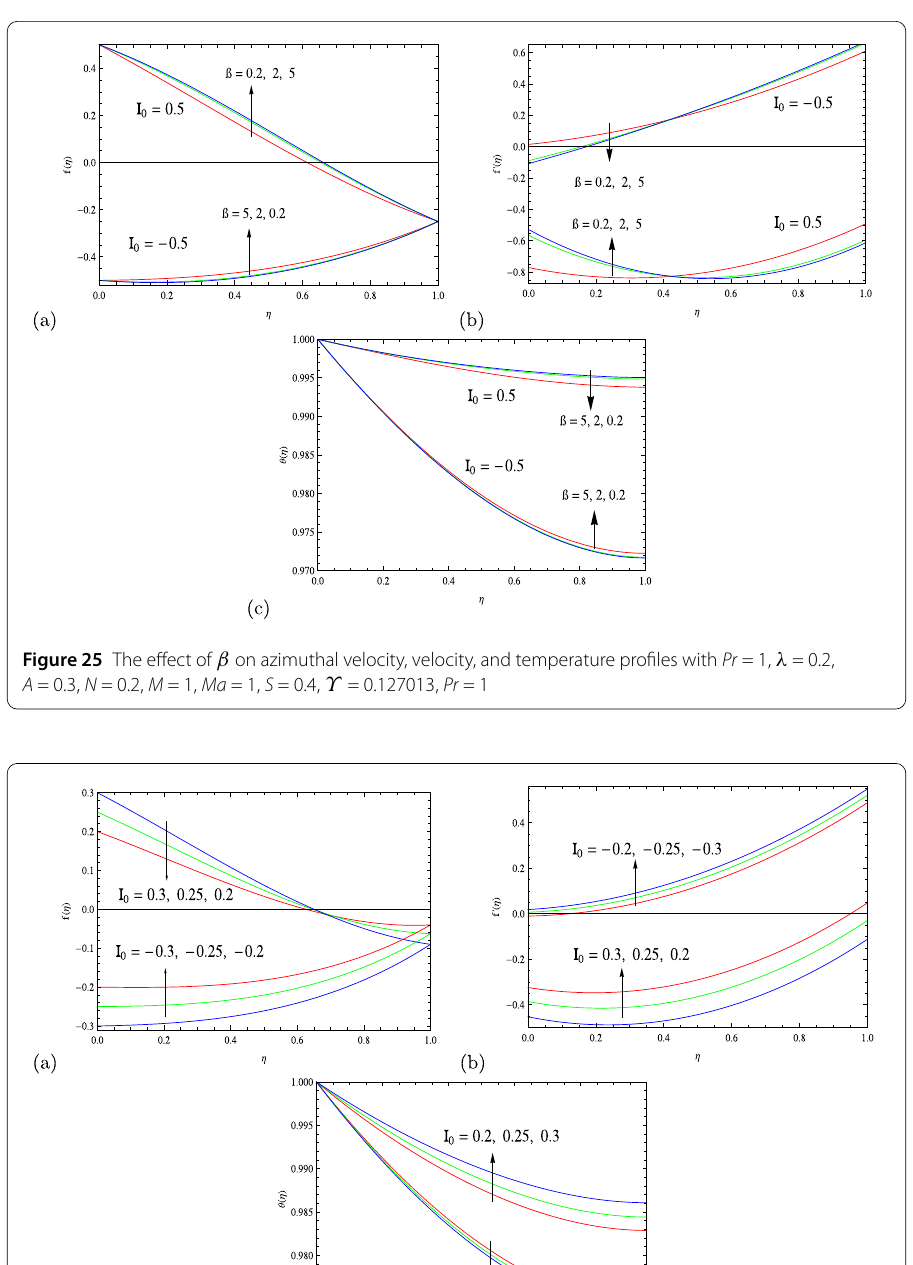
creases as shown in Fig. 25(b). It is also observed that in the injection case the azimuthal velocity is lower than that of the suction case for a fixed value of I 0 = 0.5,–0.5, λ = 0.2, Ma = 1.0, A = 0.3, N = 0.2, S = 0.4, M = 1.0, Pr = 1.0, and β 2 = 0.127013. Furthermore, the increasing of β increases temperature in the suction case. For the injection case,